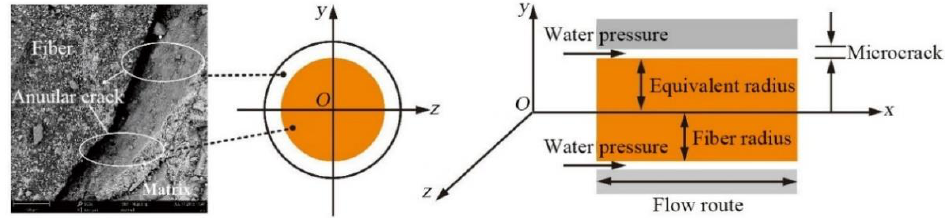
Figure 14. Concentric annular slit.